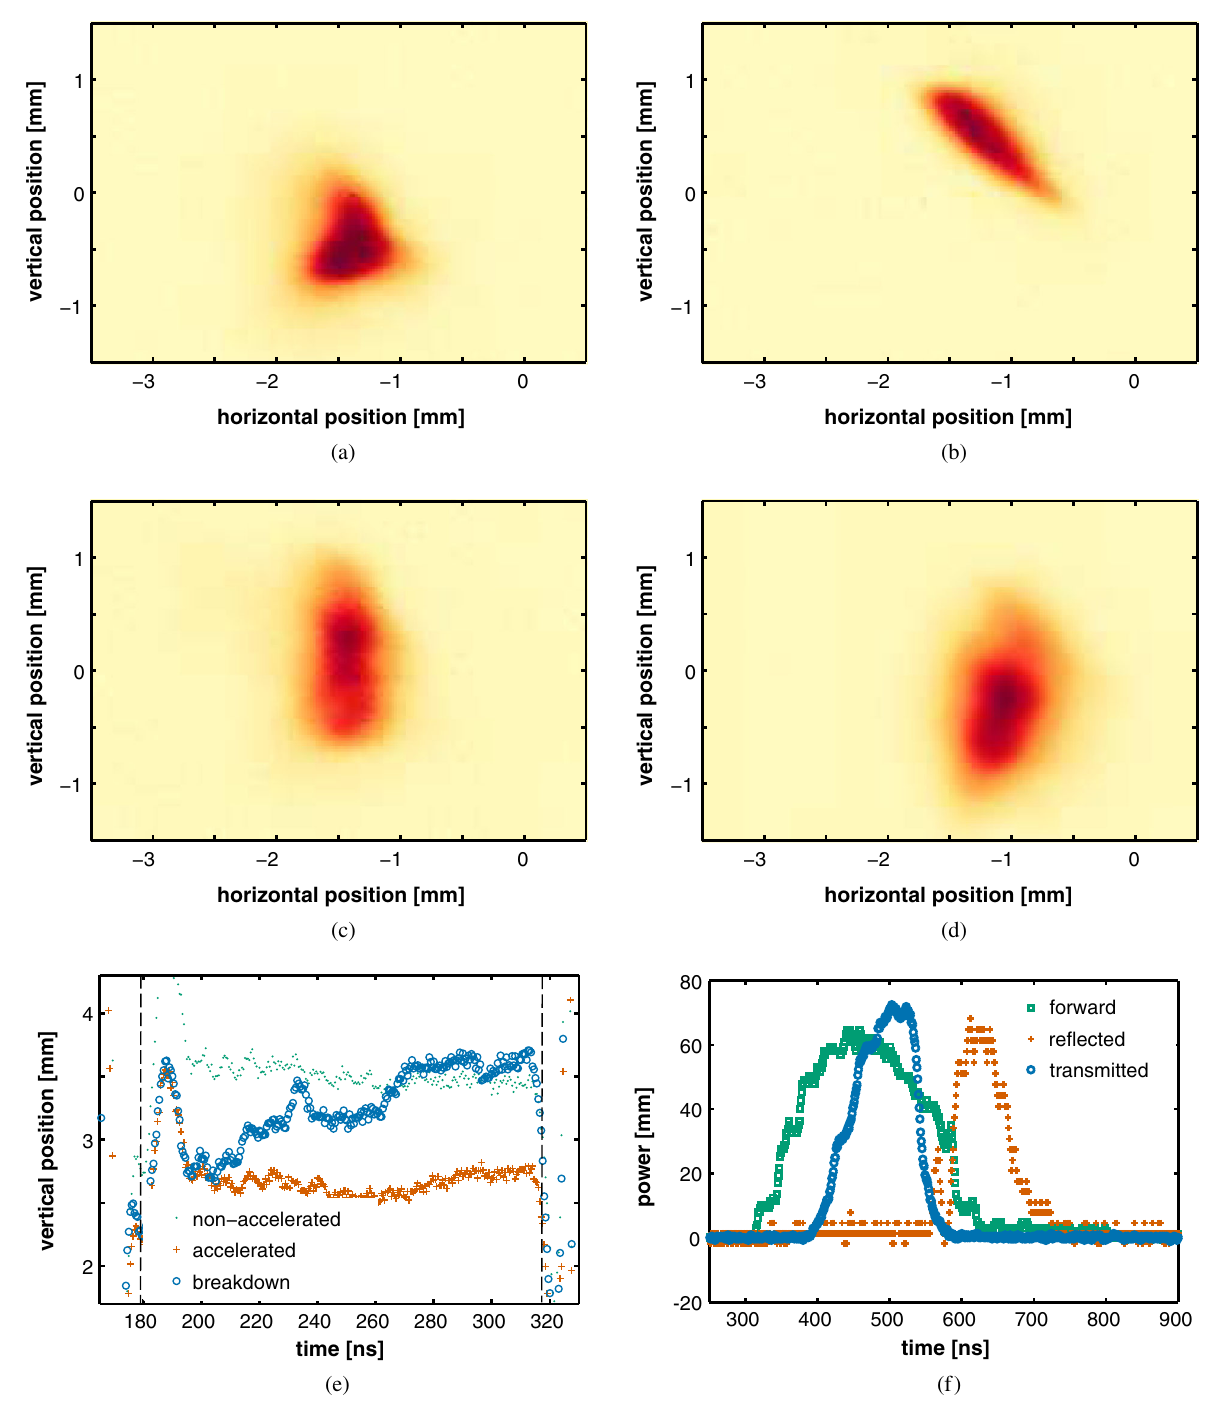
FIG. 5. Collection of measurements from three consecutive bunch trains and prediction of the beam spot in case of rf breakdown: (a) accelerated bunch train; (b) nonaccelerated bunch train; (c) bunch train corresponding to a rf breakdown in the accelerator structure; (d) prediction of the beam spot in case of rf breakdown; (e) beam position measurements; (f) power measurements corresponding to a rf breakdown in the accelerator